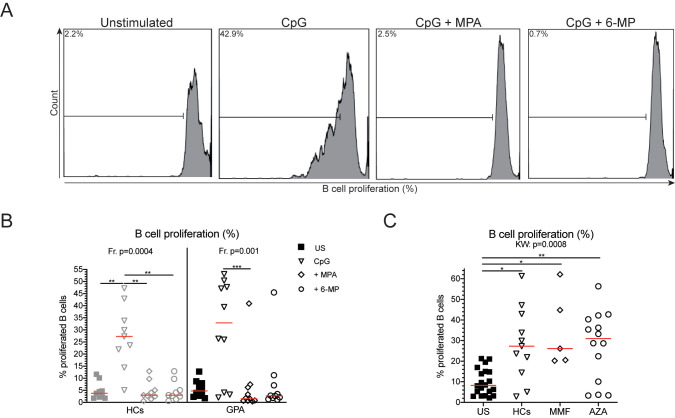
Decreased B cell proliferation upon MPA and 6-MP stimulation.A. A representative gating example of proliferating B cells. Within CD19+CD22+ B cells, B cell proliferation was determined using histograms. Gates were set on the unstimulated sample. B. B cell proliferation is given for both HCs and GPA patients for the unstimulated (US; squares), and CpG- (open triangles), MPA+CpG-(open diamonds), and 6-MP+CpG (open circles) stimulated samples. C. B cell proliferation is depicted for unstimulated (US) PBMCs (squares), HCs (open triangle), MMF-treated (open diamonds) and AZA-treated patients (open circles). Red lines represent the median value. *p<0.5, **p<0.01, ***p<0.001.